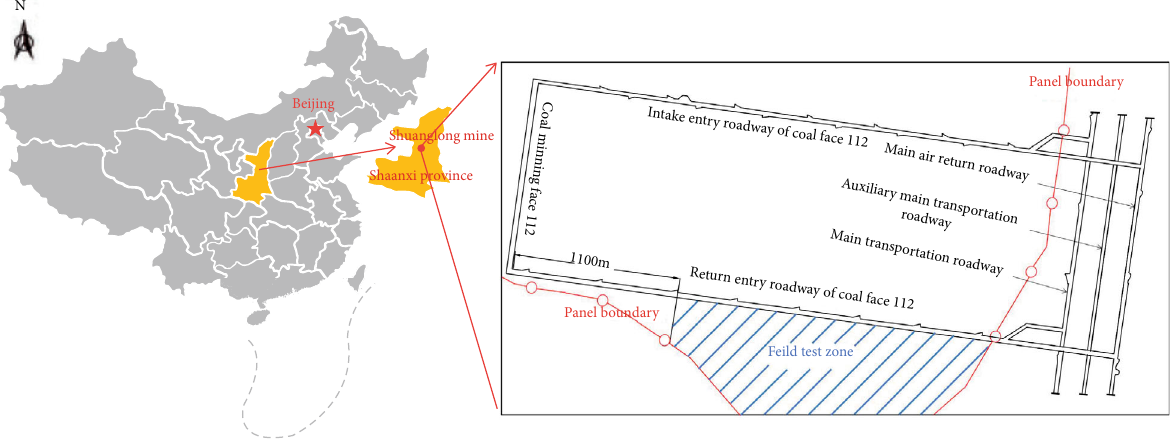
Figure 1: Location of the fi eld test zone in the target coal mine.